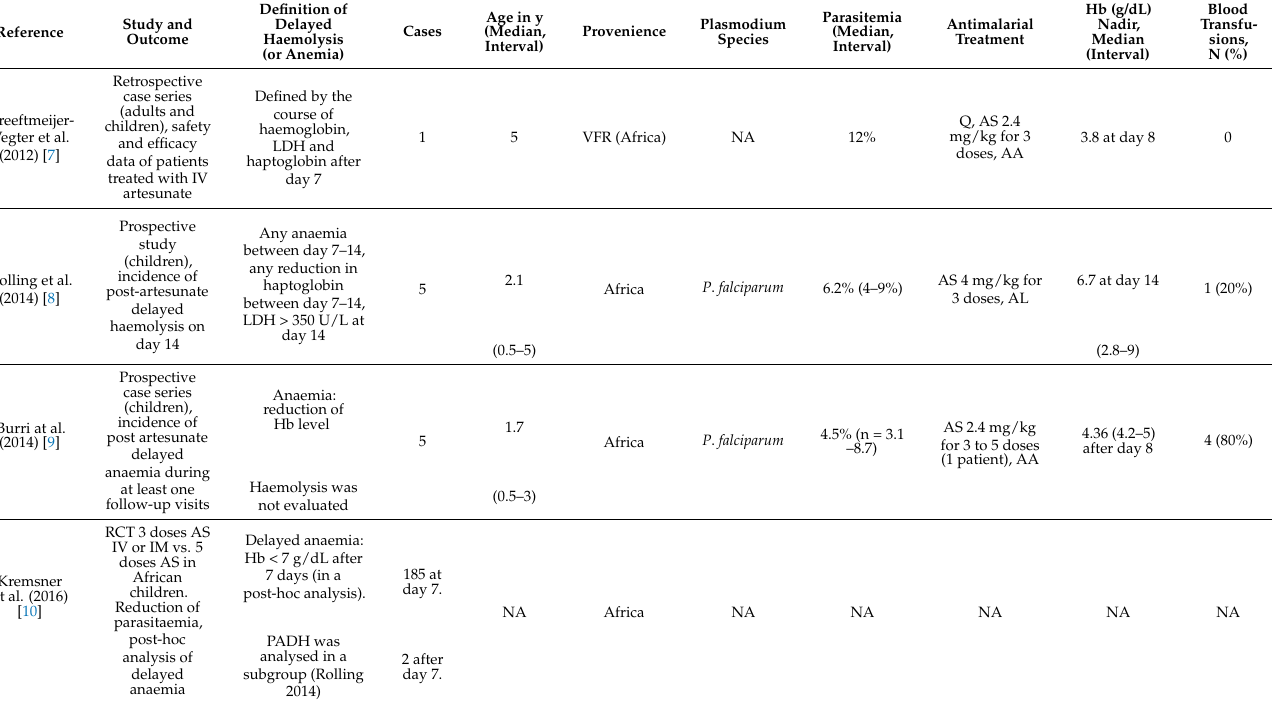
Table 1. Previous cases of post artesunate delayed anaemia or haemolysis